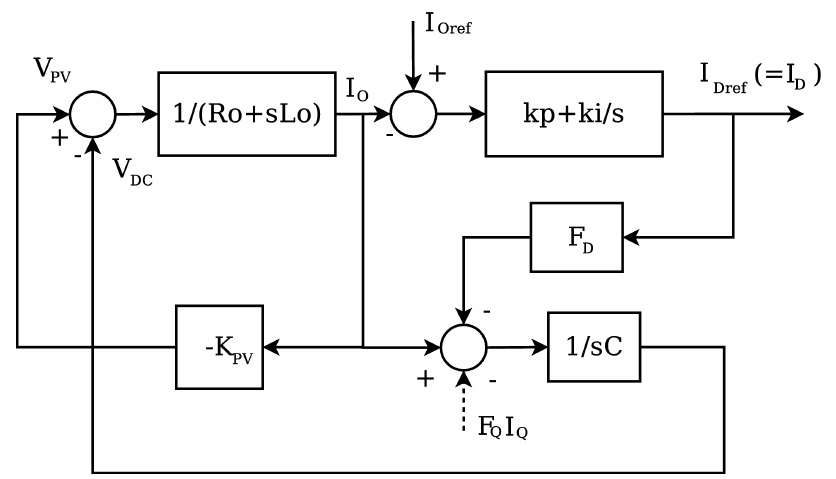
Figure 4. Scheme of the linearized outer control loop of the